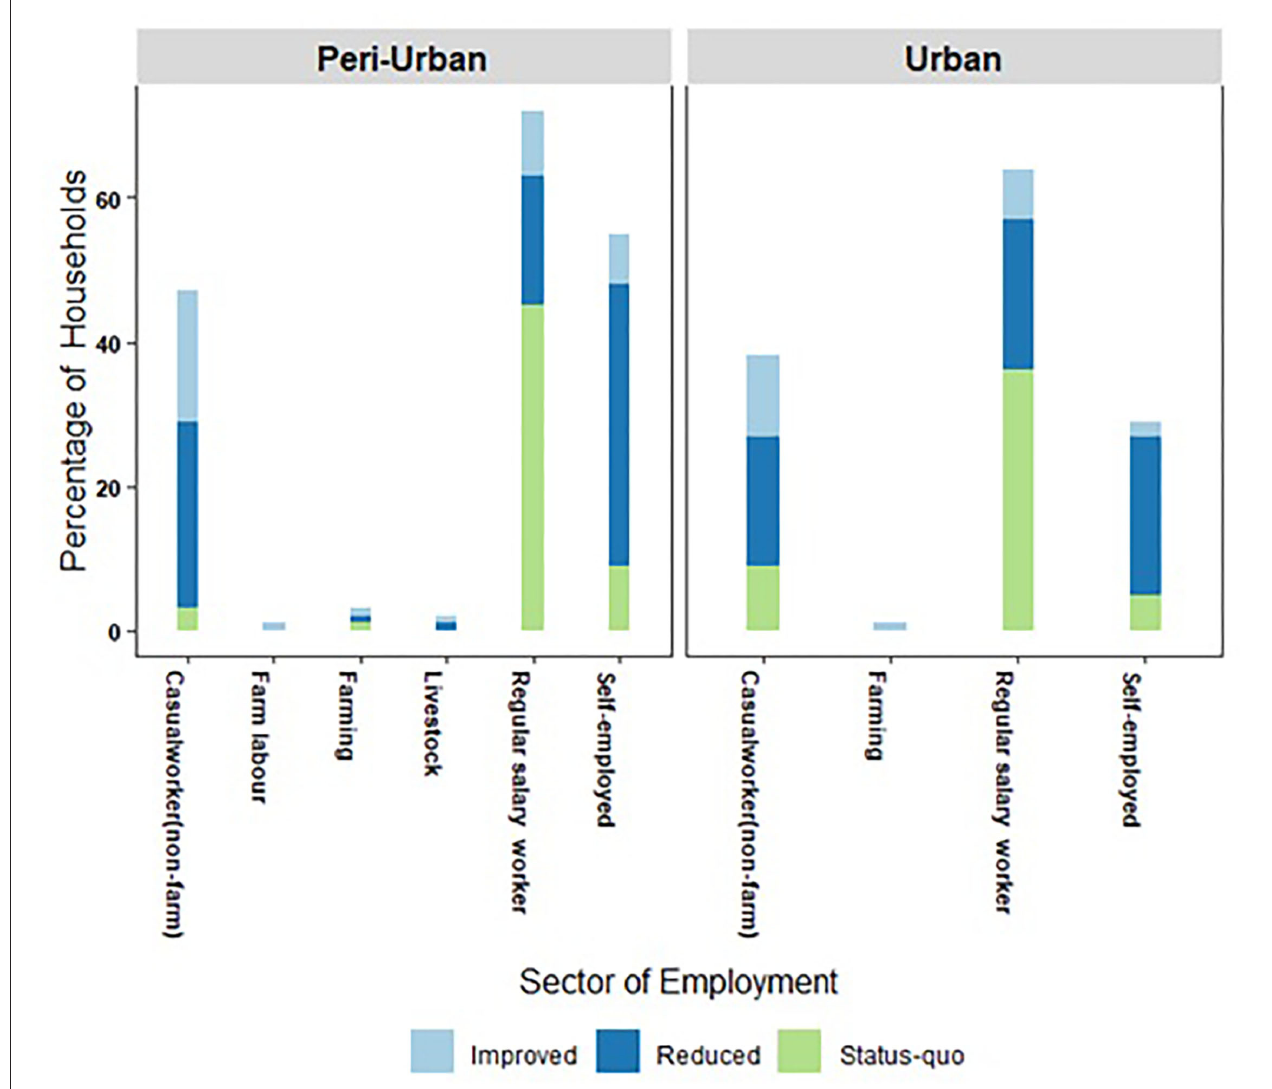
FIGURE 4 | Change in household income status (improved/reduced/status quo) relative to pre-pandemic income levels experienced by different categories of households (categorized by type of employment) in urban and peri-urban areas of Hyderabad, India.